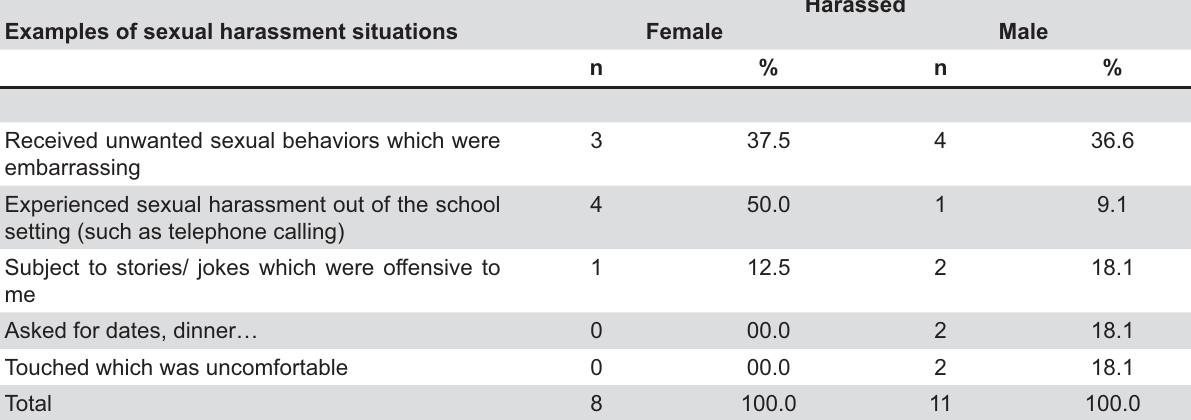
Table 1- Sexual harassment experiences reported by dental students who cited the patient as the